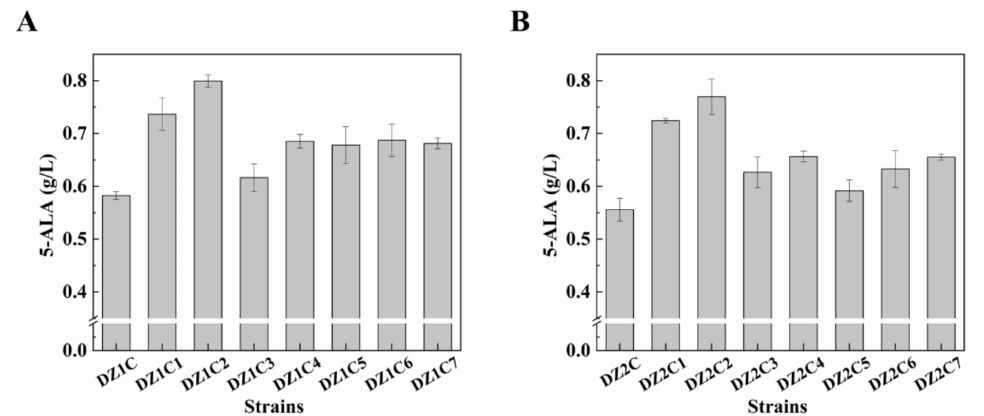
Figure 7. Effect of combined expression perturbations of key genes on 5-ALA synthesis. ( A ) The effects of overexpression of genes including NCgl1445 (DZ1C1), iolT1 (DZ1C2), pyk2 (DZ1C3), aceA (DZ1C4), afuABC (DZ1C5), pstSCAB (DZ1C6), and ugpQ (DZ1C7) on 5-ALA biosynthesis compared to DZ1C (JSDZ1 harboring pEC-XK99E). ( B ) The effects of overexpression of genes including NCgl1445 (DZ2C1), iolT1 (DZ2C2), pyk2 (DZ2C3), aceA (DZ2C4), afuABC (DZ2C5), pstSCAB (DZ2C6), and ugpQ (DZ2C7) on 5-ALA biosynthesis compared to DZ2C (JSDZ1 harboring pEC-XK99E). The error bars represent the standard deviations from three independent